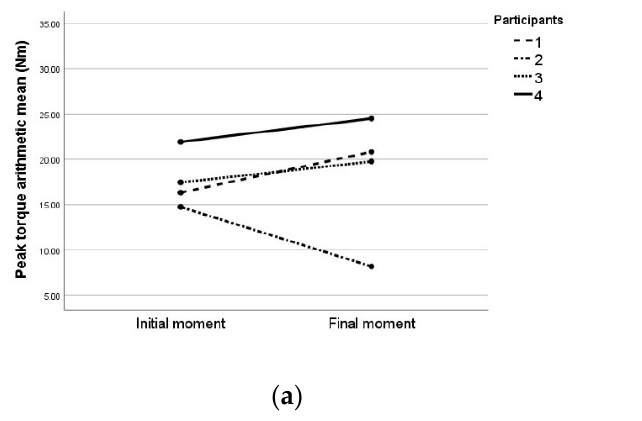
Figure 8. Arithmetic means of peak torque in each participant: ( a ) arithmetic means of peak torque in each participant from group 1 with COVID-19; ( b ) arithmetic means of peak torque in each participant from group 2 without COVID-19. Table 2. Mean peak torque (Nm) during MVIC for study groups in initial and final